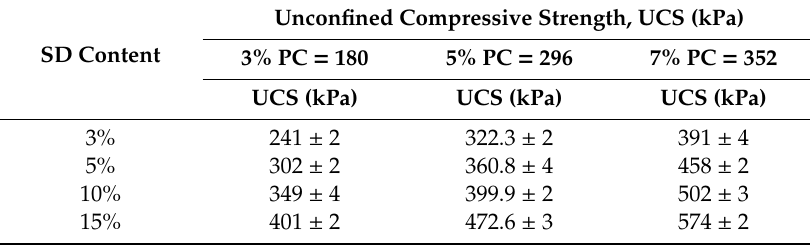
Table 4. UCS results before sulphate exposure in presence of SD (3 days curing).